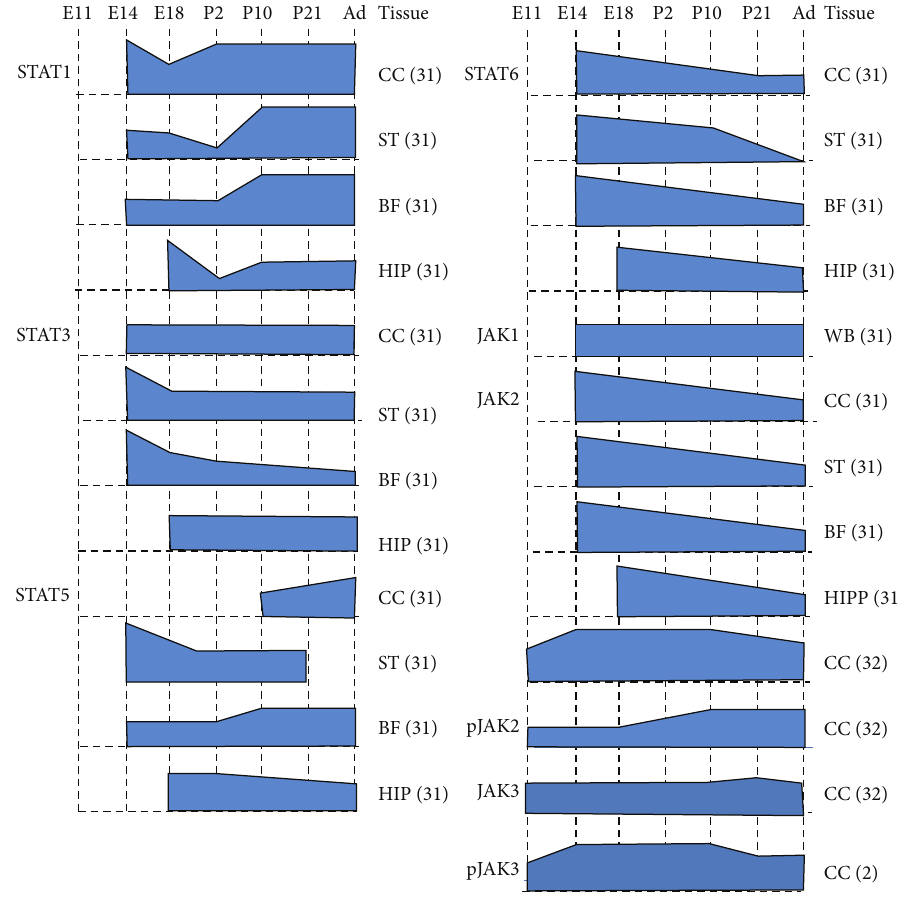
Figure3:JAK(JAK1,JAK2,andJAK3),phosphorylatedJAK(pJAK2andpJAK3),andSTAT(STAT1,STAT3,STAT5,andSTAT6)proteinlevels in the mammalian nervous system throughout various developmental stages until adulthood. Drawing is not to scale. BF: basal forebrain; CC: cerebral cortex; HIP: hippocampus; ST: striatum; WB: whole brain. (1) Sprague Dawley rat [31]; (2) mouse